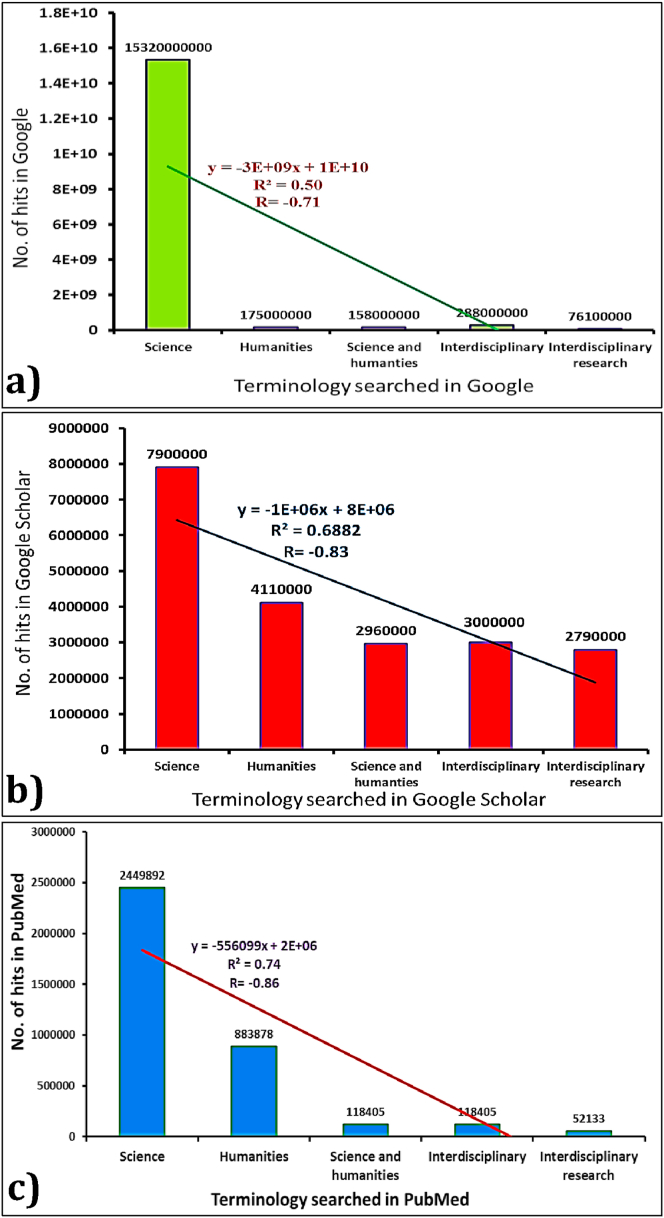
Number of articles or hits obtained in Public Library of Medicine (PubMed), Google and Google scholar using key words science, humanities, science and humanities, interdisciplinary and interdisciplinary research. a. Number of articlea (hits) in Google, b. Number of articles (hits) in Google scholar and c. Number of articles (hits) in PubMed.